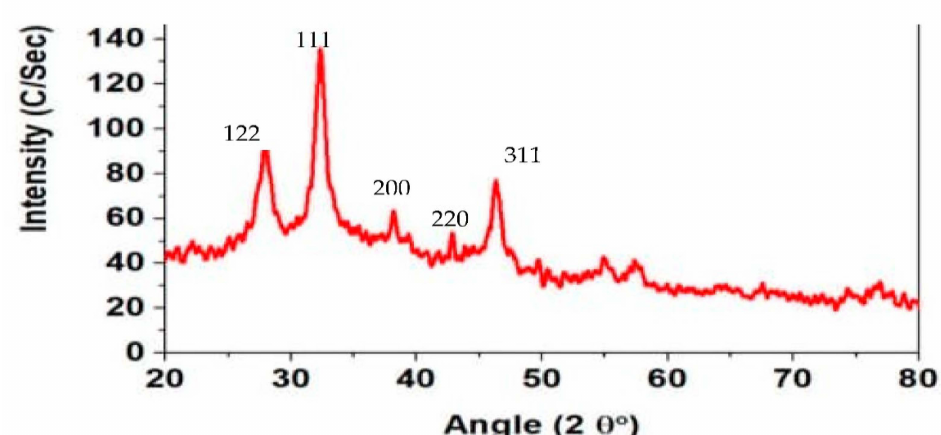
Figure 3. XRD spectrum of silver nanoparticle of the C. roseus plant. The XRD peaks of C. roseus AgNps at 2 θ values of 28.00 ◦ , 32.00 ◦ , 38.00 ◦ , 44.00 ◦ and 45.00 ◦ represent the planes of silver at 122, 111, 200, and 220 respectively. These planes are matched by standard powder diffraction card of JCPDS, silver file no. 04-0783. The XRD results confirmed the formation of crystalline C. roseus AgNps which was matched by silver planes as shown in the figure.